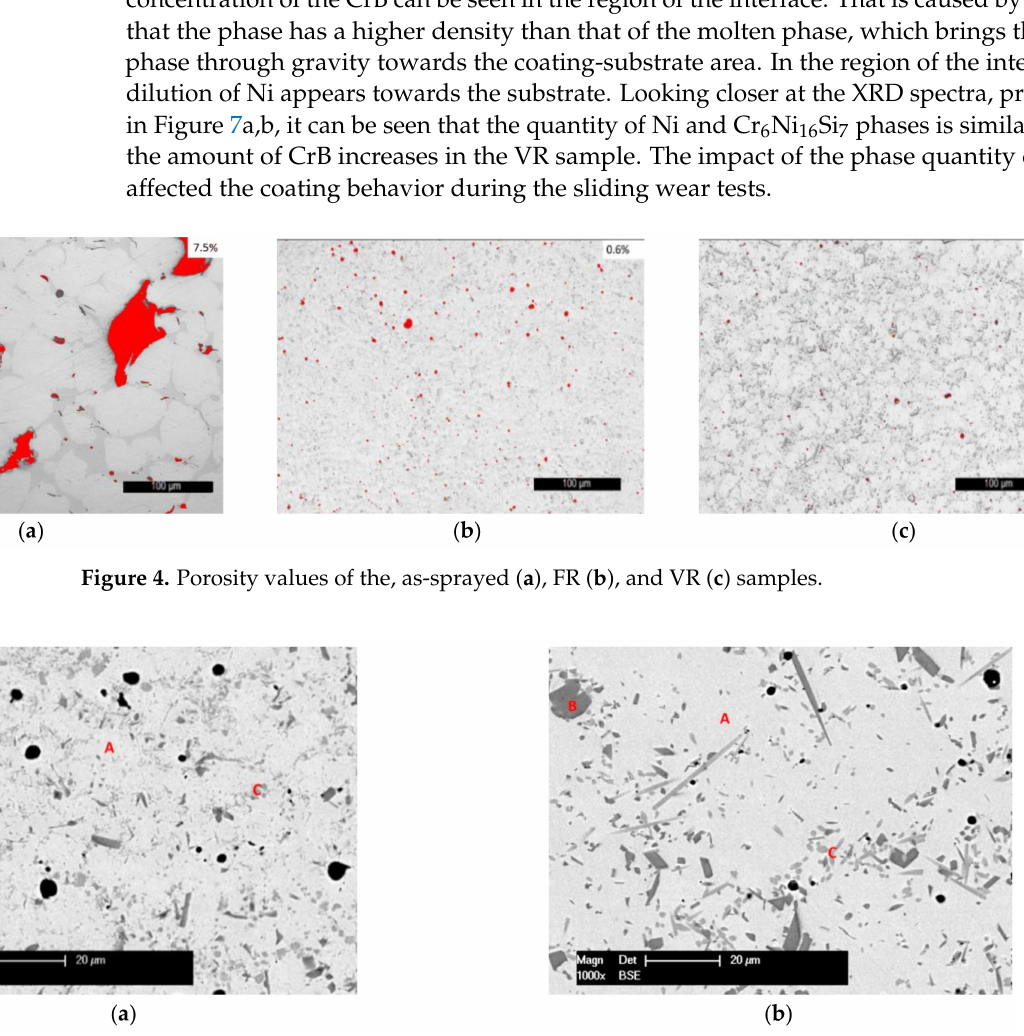
Figure 5. BSE micrograph of a detail of the FR ( a ) and VR ( b ) coatings.